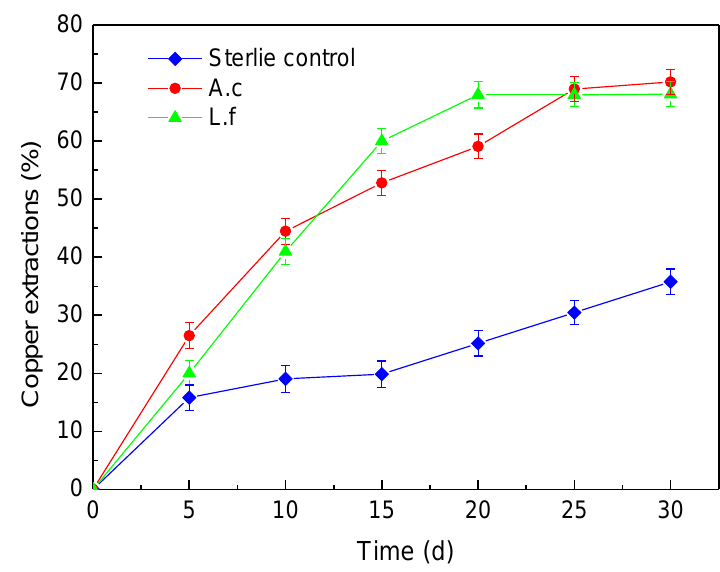
Figure 6. Variations of copper extraction rate during bioleaching.